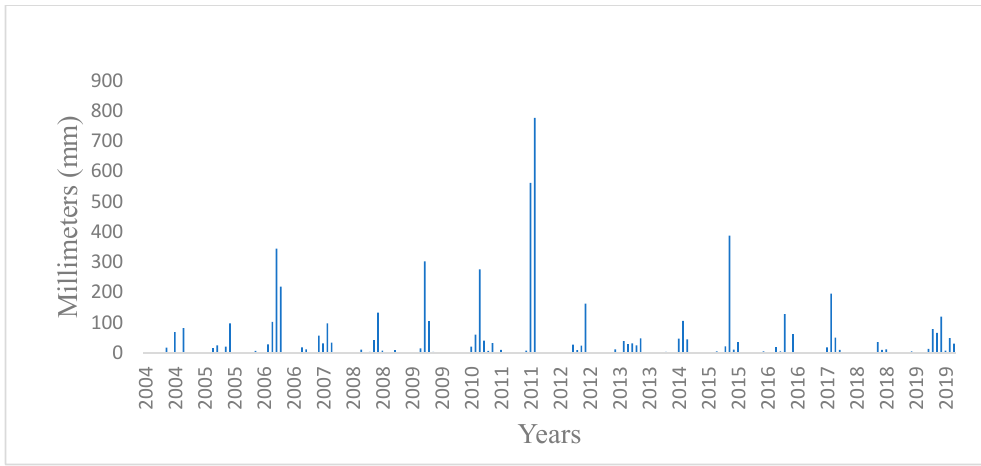
Figure 5. Annual cycle of the precipitation the input data starts from 2004 to 2019.